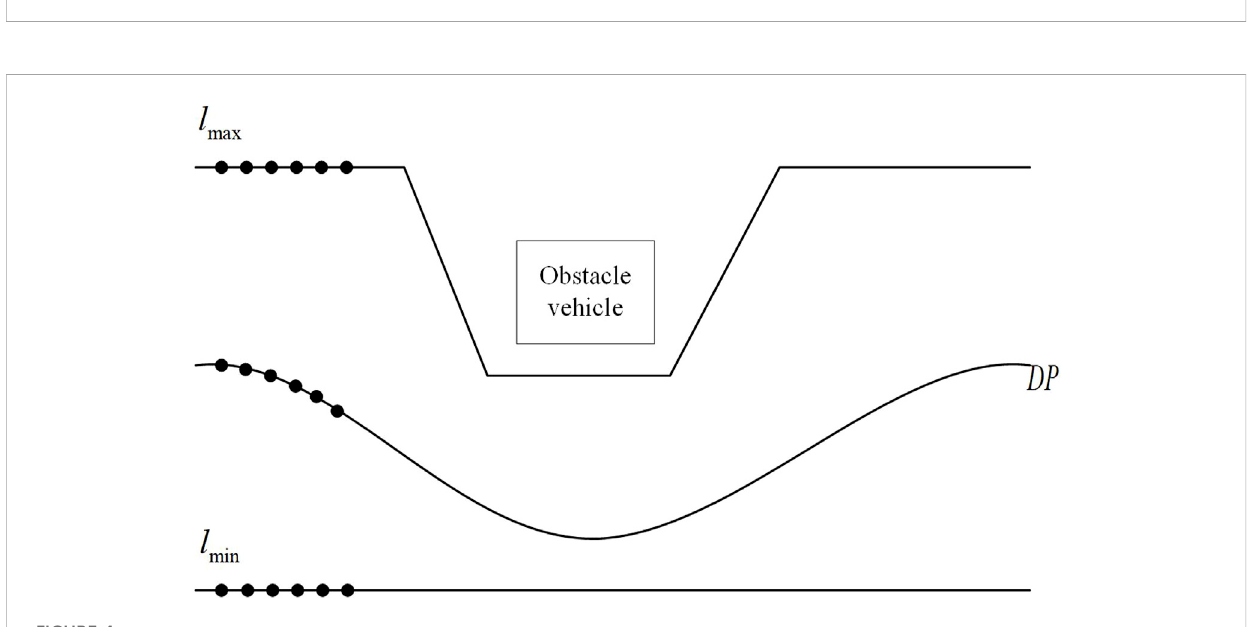
Figure 4. The advantage of the iterative method for solving quadratic